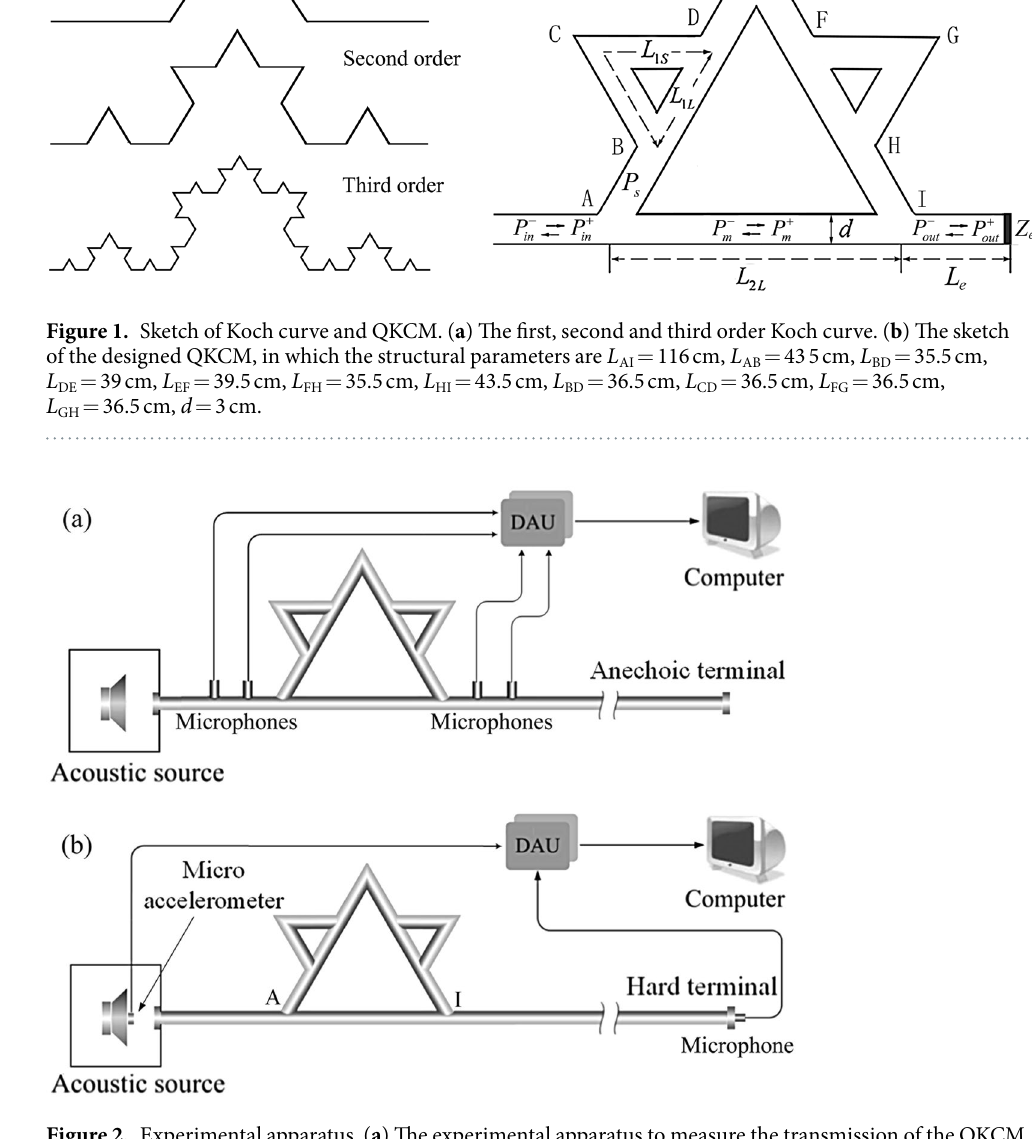
Figure 2. Experimental apparatus. ( a ) The experimental apparatus to measure the transmission of the QKCM with four-microphone method. ( b ) The experimental system to measure the group velocity in the QKCM. The structural parameters of the QKCMs in both systems are the same as those shown in Fig.